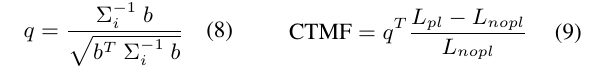
Reference spectra without plume are used to provide the ob- served transmission following the equation (5). Then, the com- parison between this transmission and theoretical transmissions from a Look-Up Table (LUT) gives access to the concentration of the